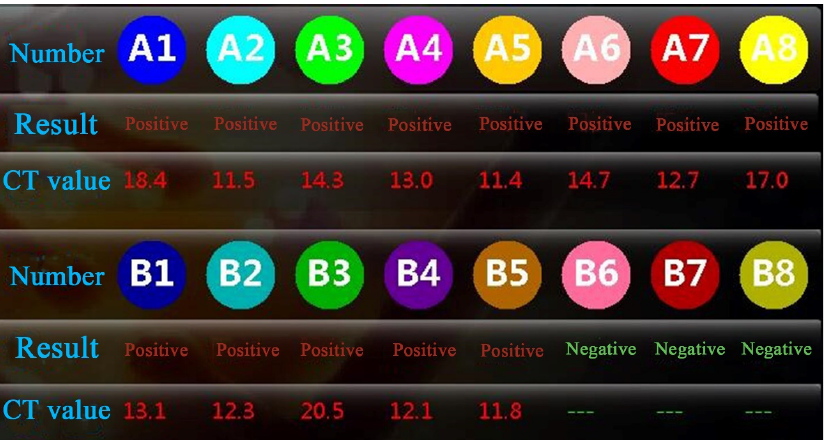
Figure 3. The results of DNA detection of PWNs from different geographical sources by EMA.A1– A8 and B1–B6 are the well numbers. The corresponding test samples of wells A1–A8 are Bx01–Bx08, and the corresponding test samples of wells B1–B4 are Bx09–Bx12; well B5 is the positive control, and well B6 is the negative control. B7 and B8 are empty slots.